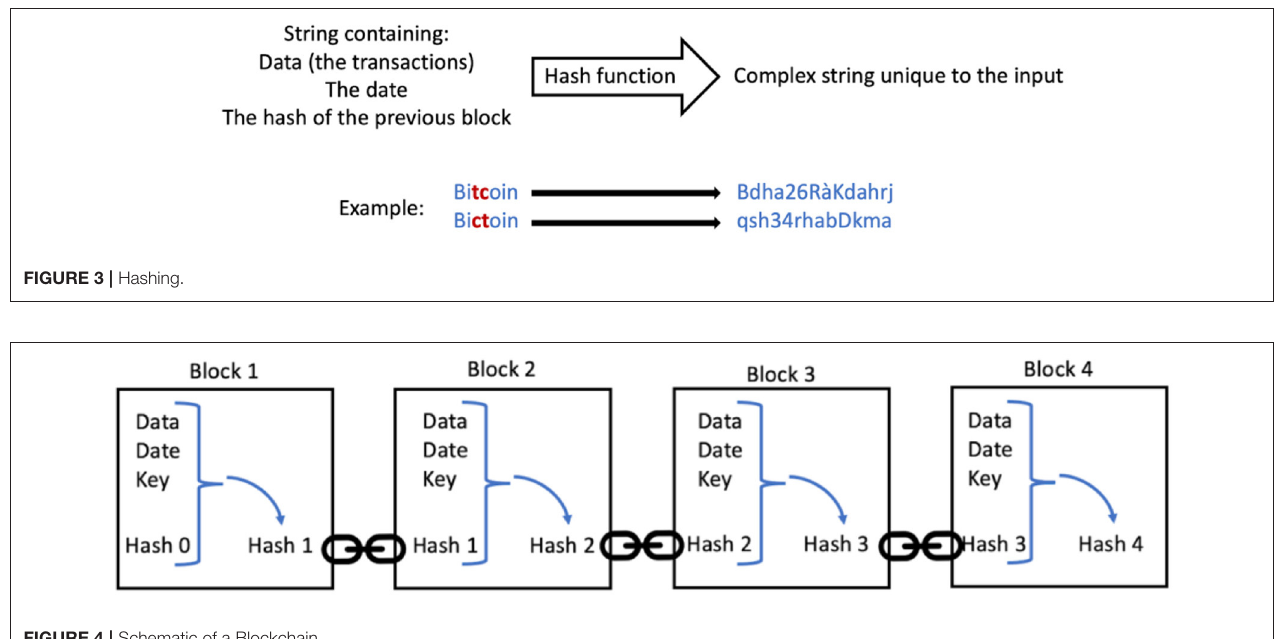
FIGURE 4 | Schematic of a